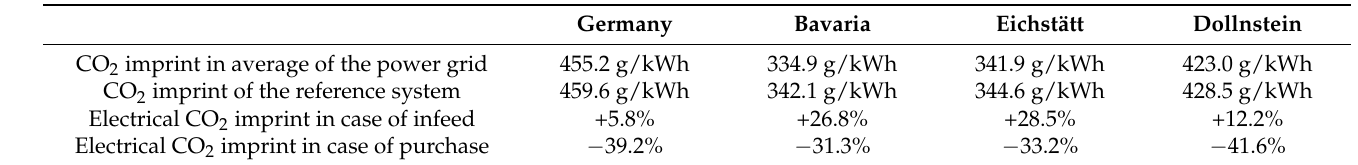
Table 5. CO 2 imprint of the system compared to the heat-controlled reference system by consideration of CO 2 emission